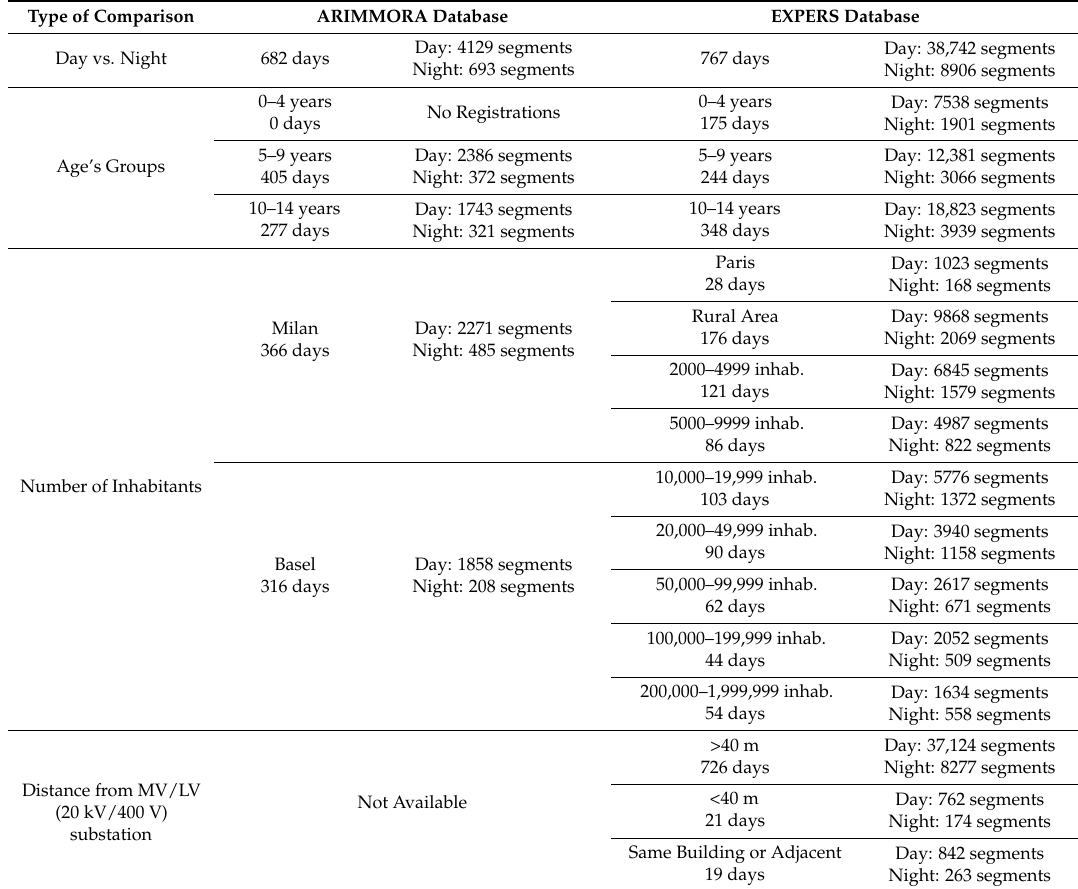
Table 2. Subdivision of the two databases to conduct analysis of children’s ELF-MF